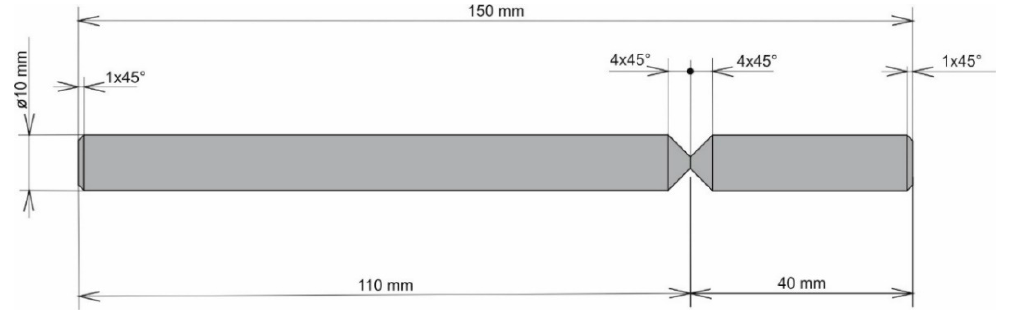
7 of 21 Figure 7. Diagram of the static tension test performed on the welded material EN AW 6063.T66 without preheating (red curve) and with preheating (blue curve) in the alpha-geometry of the weld surface. Before fatigue testing, the value of the current material strength after welding was equal to the static strength of the tested sample. In the process of the fatigue test, degradation of the residual value takes place. The quantity in a specific moment reaches the critical value of the maximum possible load, and this results in the origin of failure. Therefore, it is recommended that all possible precautions leading to an increase in the strength of the welded joint be taken. As a result, the research dealing with the impact of the welding area shape on the welded joint strength was included in the methodology of forming the samples. The deficiency of the alpha-geometry (Figure 5) of the weld surface resulted in widespread failures in the welded joint. More specifically, improper welds were created, as shown in Figure 8, and the melting of the weld surface did not take place either. The proof of this statement is the macrostructure of the fracture area on the tested sample, in which we can observe grooving that was caused by the machining tool during the preparation of the welding area. Only the filler material was molten, and its thickness was insufficient after machining in accordance with the geometry of the samples for the fatigue evaluation (or the tension tests). It was formed by the thick ring of the filler material, which was softened by welding, so we cannot speak of sufficient joint strength. Figure 8. Macrostructure of the fracture areas with the alpha-geometry of the weld surface. Removal of the failures of this origin would be relatively easy with more extensive proportions